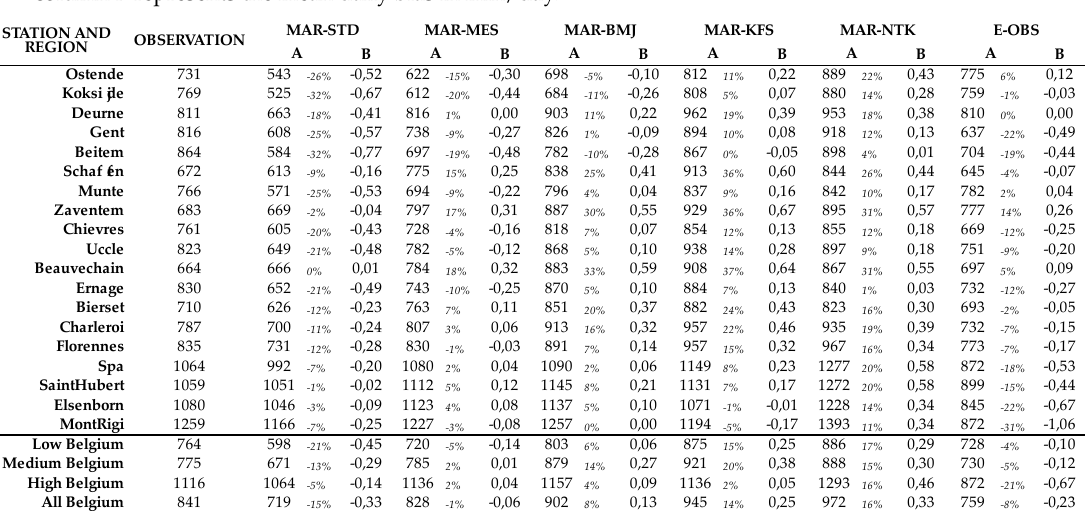
Table 1. Comparison over 2008–2014 of annual mean precipitation from SYNOP weather stations (and all stations in each region) with MAR experiments and E-OBS. Column A represents precipitation simulated by MAR (resp. provided by E-OBS) in mm/year and the corresponding bias in % and column B represents the mean daily bias in mm/day.